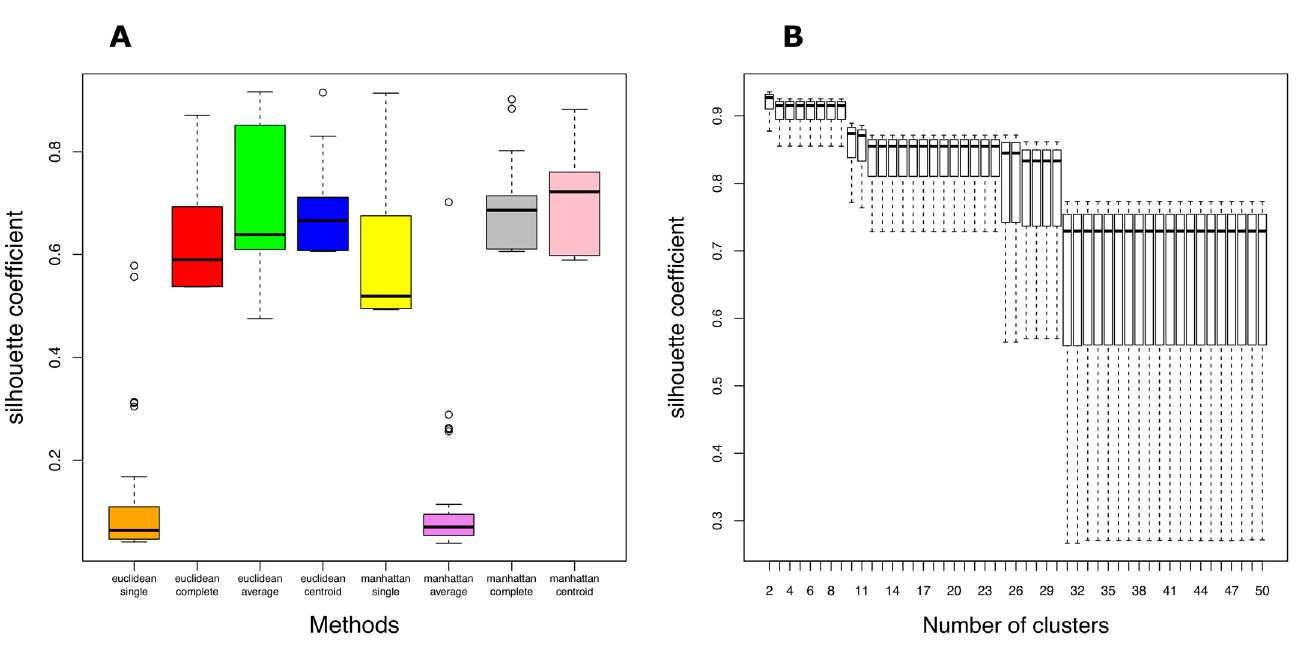
Fig 13. Silhouette coefficient distributions for agglomerative hierarchical clustering method. Silhouette coefficient distributions computed for different configurations (Panel A), and for different number of clusters (Panel B) only for the chosen configuration Manhattan-centroid.